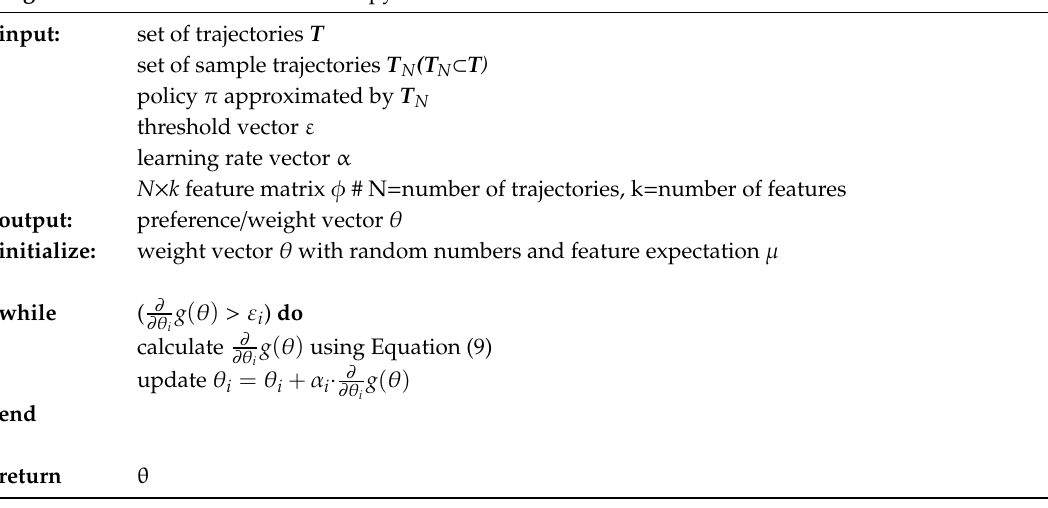
Algorithm 1: Resident Relative Entropy